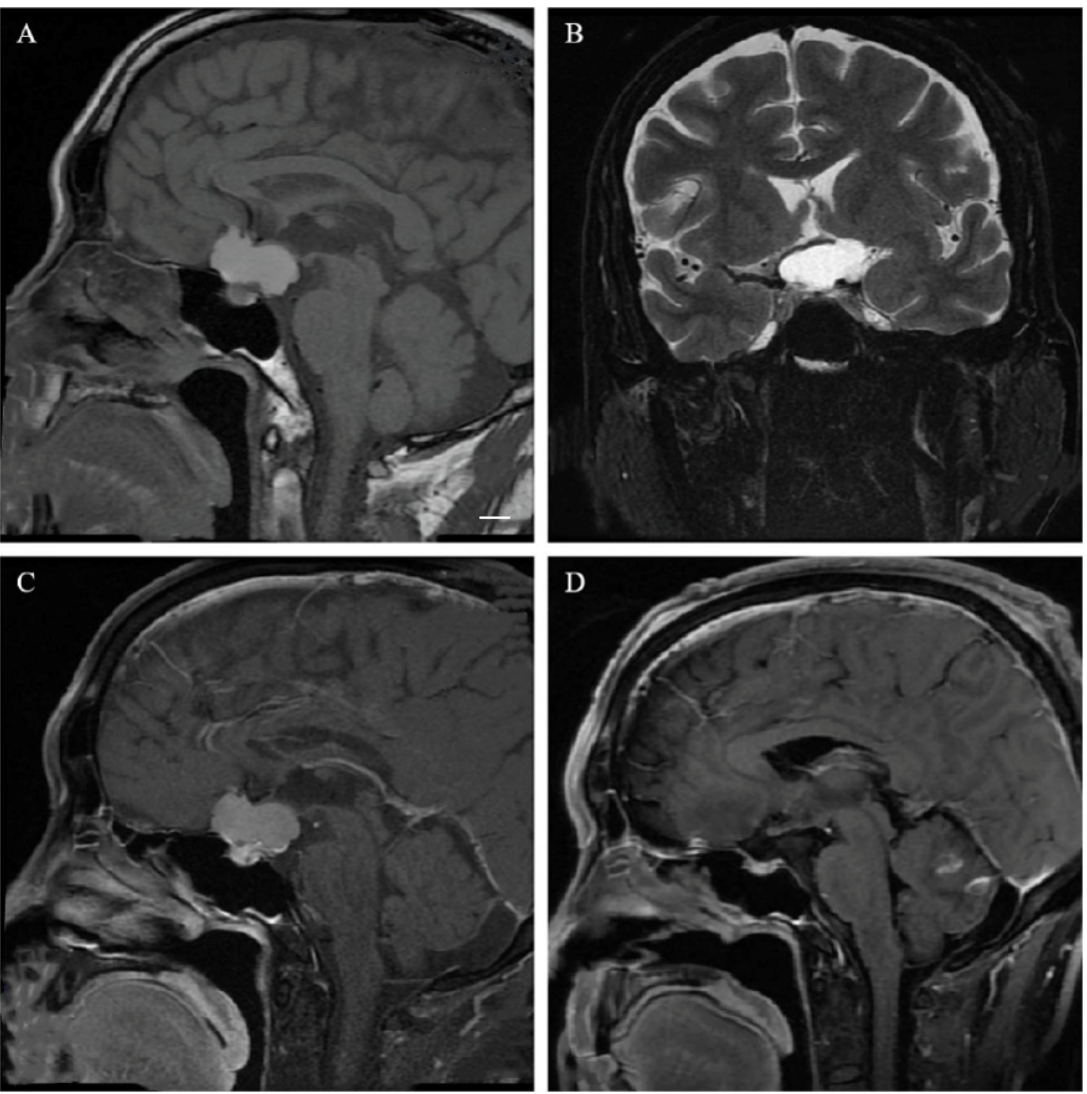
Figure 3. A 61-year-old male, vision loss for 3 months with normal endocrine hormone levels. An MRI showed a suprasellar cystic space-occupying lesion. Slightly hyperintense signal on preoperative T1 and T2 weighted imaging ( A , B ), slightly enhanced on T1-weighted contrast-enhanced MR image ( C ). The hypothalamus was involved in the tumor, but the hypothalamus was still identifiable (Puget grade 1). The pituitary stalk was identified and preserved during surgery, and postoperative MRI confirmed total resection ( D ). Postoperative endocrine hormone levels were normal, with the absence of diabetes insipidus. Scale bar: 1